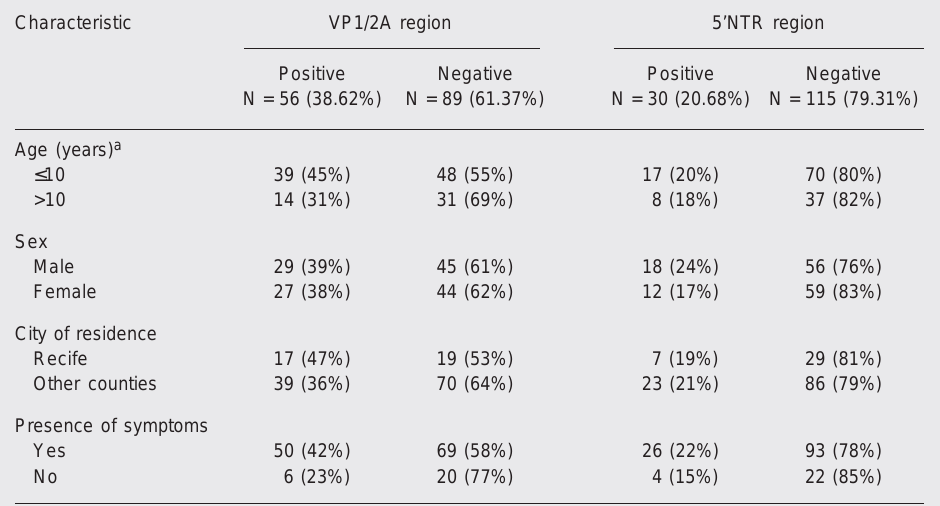
Table 1. Characteristics and risk factors for hepatitis A virus infection in the population